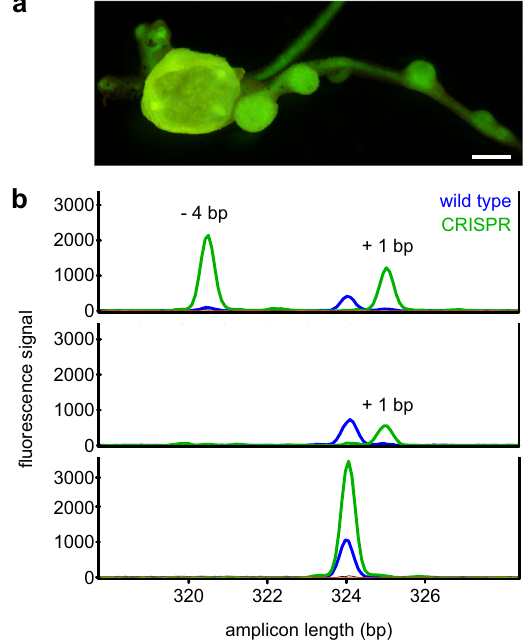
Fig. 1 | Fluorescence of transformed roots and AFLP analysis of nodule pools. a Transgenic hairy roots expressing GFP as selection marker. Images were taken with a binocular equipped with a GFP-long path fi lter. Scale bar, 500 µ m. b AFLP analyses with capillary electrophoresis for mutant identi fi cation on three example chromatograms. Green peaks represent JOE-labelled amplicons from XMPP- CRISPR-transformed nodules. Blue peaksrepresent 6-FAM-labelled(wild type size) amplicons from control nodules transformed with an empty vector. From top to bottom, AFLP analysis of three independent nodule pools showing biallelic null- mutant, homozygous null-mutant and wild type patterns. Analysis was performed once per sample and the mutations of the samples identi fi ed as null-mutants were further con fi rmed by Sanger sequencing.